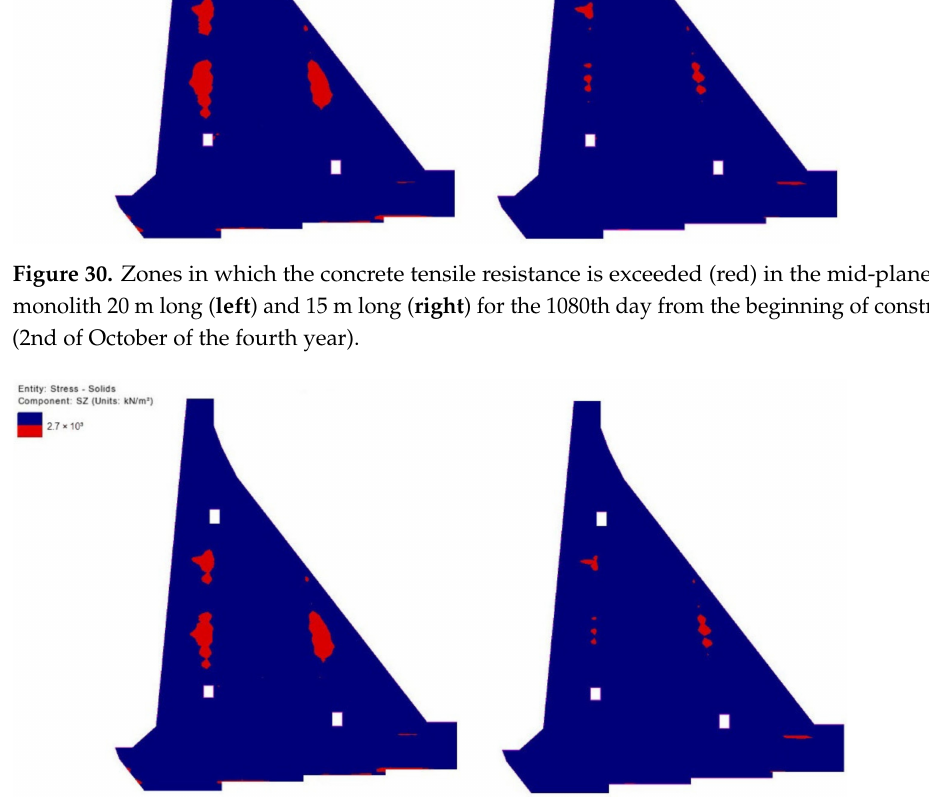
Figure 31. Zones in which the concrete tensile resistance is exceeded (red) in the mid-plane of the monolith 20 m long ( left ) and 15 m long ( right ) for the 1804th day from the beginning of construction (25th of September of the sixth